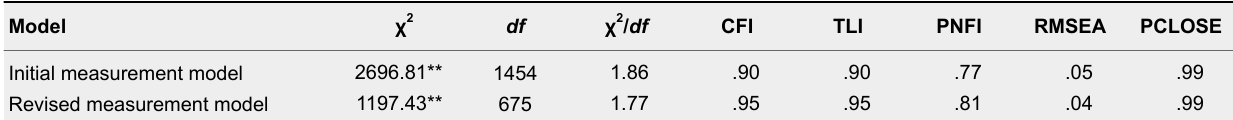
Goodness-of-Fit Statistics for the Estimated Measurement Models Model χ 2 df χ 2 / df CFI TLI PNFI RMSEA PCLOSE Initial measurement model 2696.81** 1454 .90 .90 .77 .05 .99 Revised measurement model